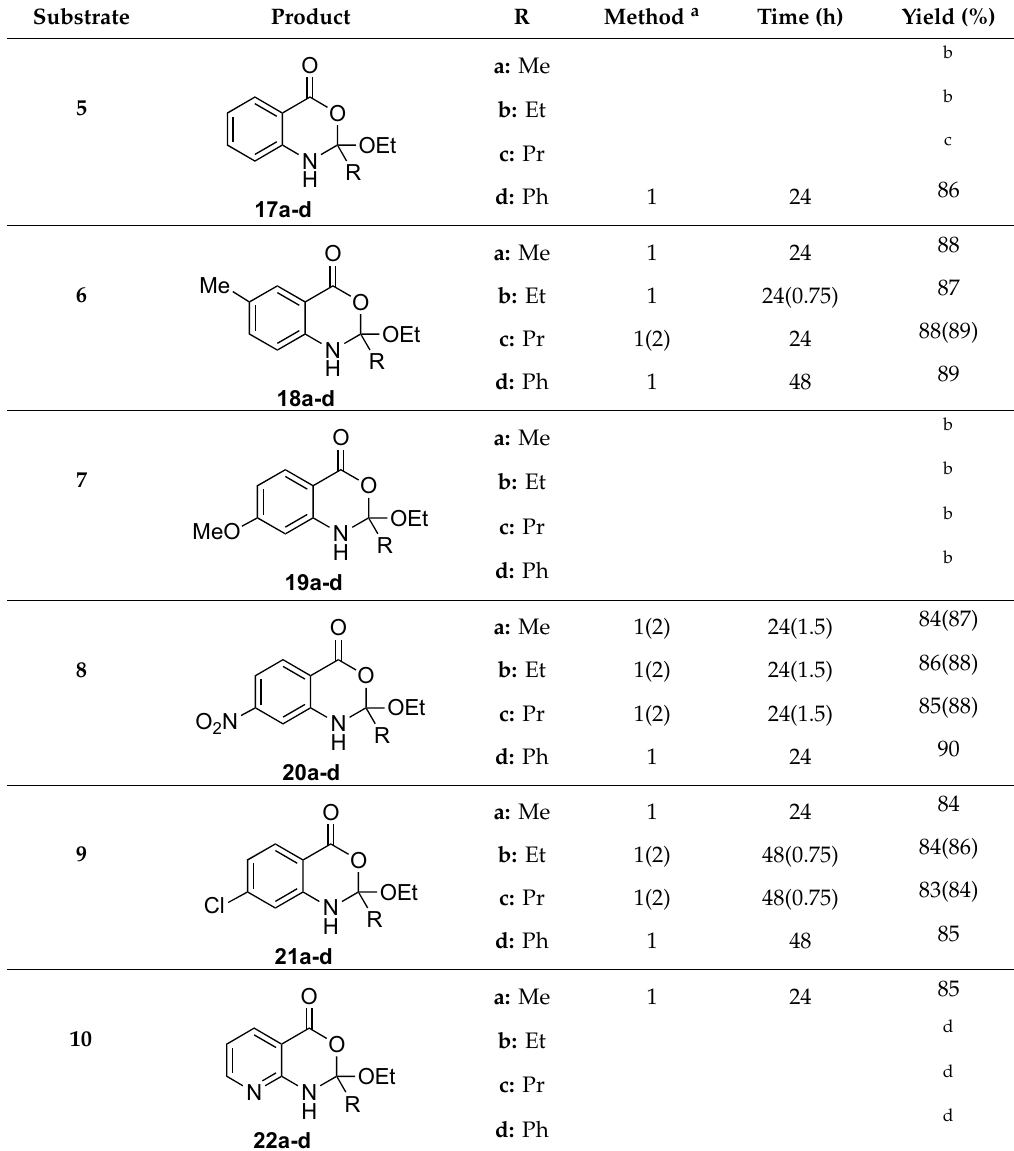
Table 2. Formation of (±)-1,2-dihydro-4 H -benzo[ d ][1,3]oxazin-4-ones. Substrate